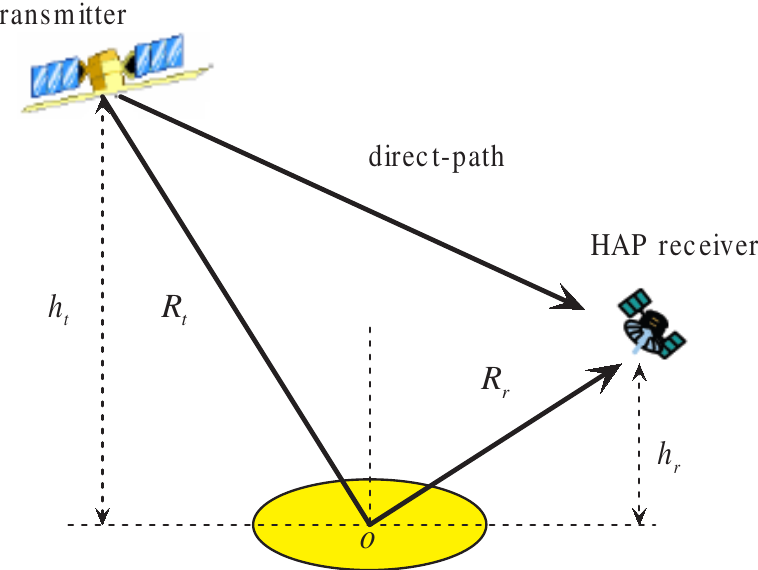
Figure 1. General geometry of HAP-borne passive BiSAR